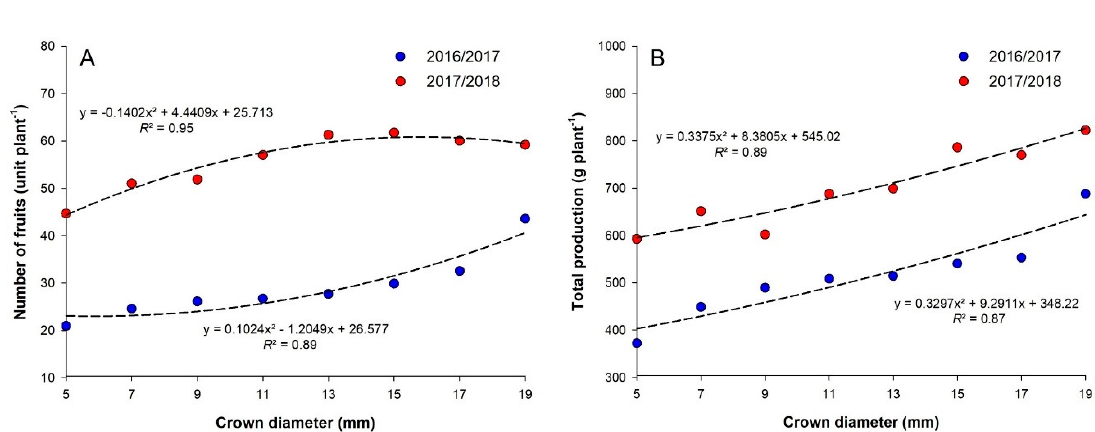
Figure 2. The number of fruits per plant ( A ) and the total production ( B ) of strawberry plants cv. ‘Pircinque,’ according to different plant crown diameters (5, 7, 9, 11, 13, 15, 17, and 19 mm) in the 2016/2017 and 2017/2018 production cycles.